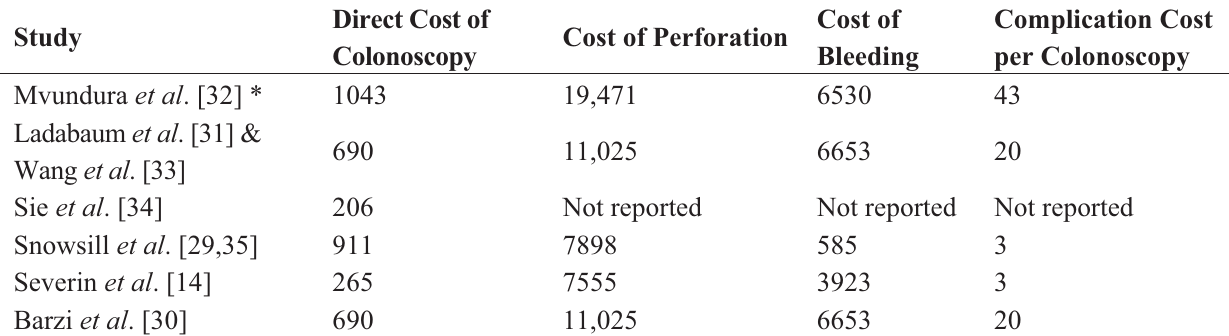
Table 4. Cost estimates in cost-effectiveness studies of routine testing for Lynch Syndrome in patients with colorectal cancer, in 2014 US